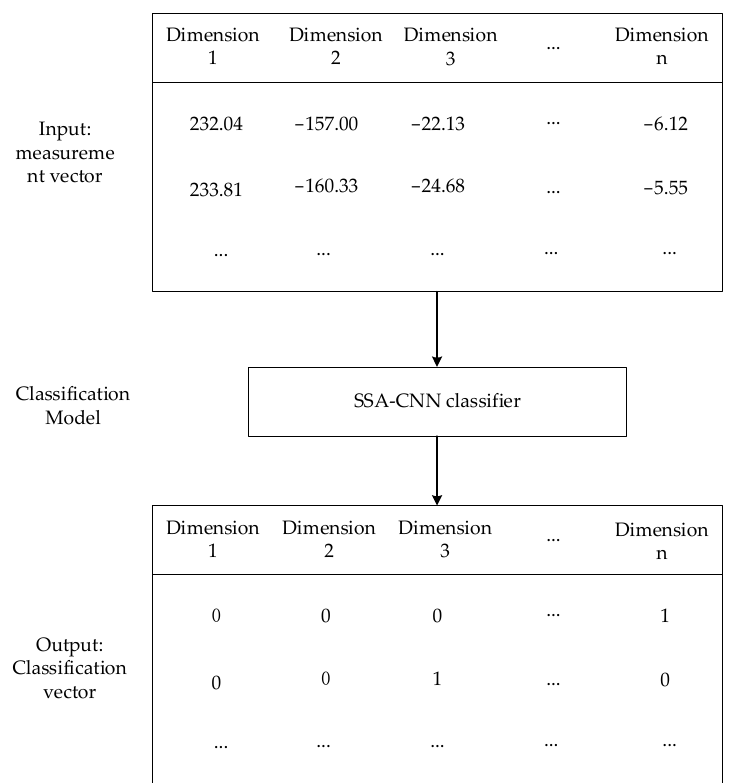
Figure 2. Structure of the localization method for FDIAs.